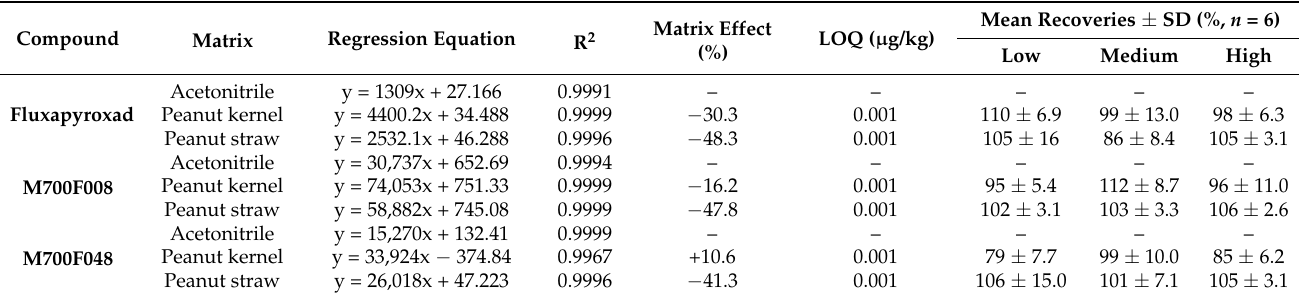
Table 1. Linear regression parameters and recoveries for the fluxapyroxad, M700F008 and M70F048 in different